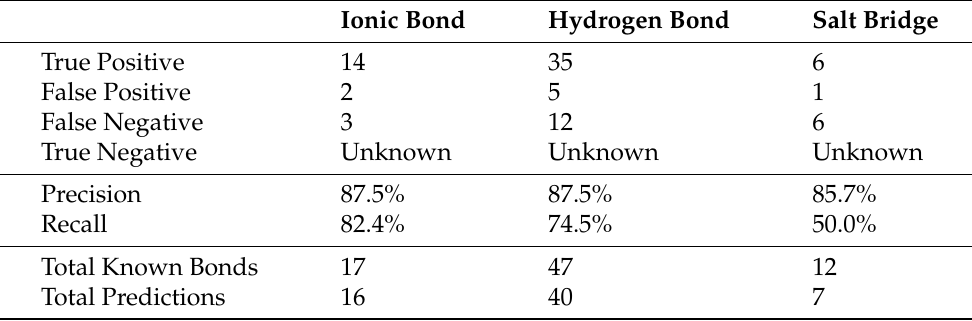
Table 1. Precision and Recall of the bond list for predicting the formation of